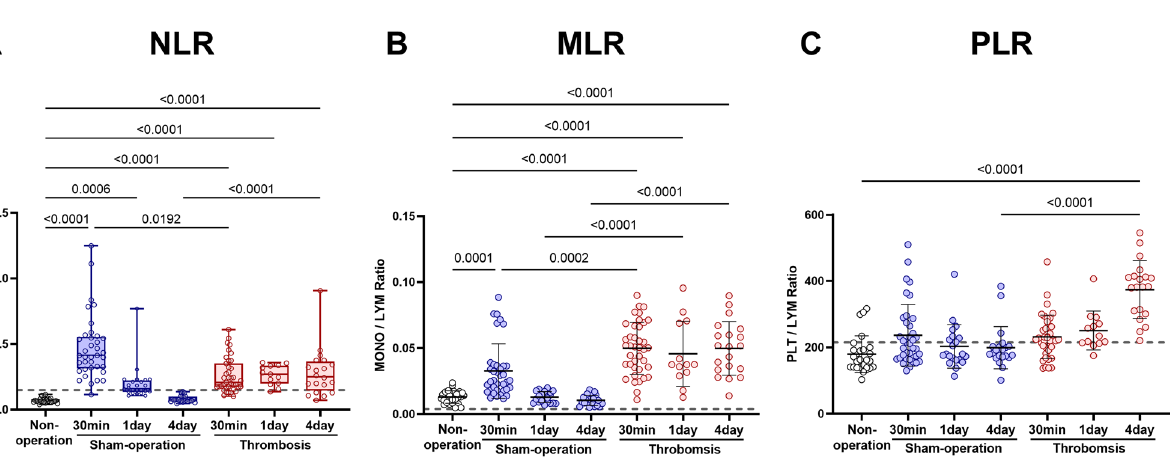
Figure 3. Comparison of neutrophil lymphocyte ratio (NLR), monocyte lymphocyte ratio (MLR), and platelet- lymphocyte ratio (PLR). ( A ) NLR. ( B ) MLR. ( C ) PLR. Box plots are for NLR: p values are from Kruskal–Wallis ANOVA and Dunn’s post-hoc tests. The box covers the interquartile interval (25–75%), with the horizontal line in the box representing the median. The whiskers outside the box correspond to the minimum and maximum values. Scatter plots (with mean ± SD) are for MLR and PLR: p values are from One-way ANOVA and Bonferroni’s post-hoc tests. Dotted lines represent proposed reference (ratio) values, calculated by using the mean values of the reference WBC differential count 6 . Note that SDs could not be calculated because of the unavailability of the raw data. Non-operation group (n = 26), Sham-operation groups (n = 37 at 30 min, n = 21 at day 1, and n = 21 at day 4), and Thrombosis groups (n = 39 at 30 min, n = 13 at day 1, and n = 20 at day